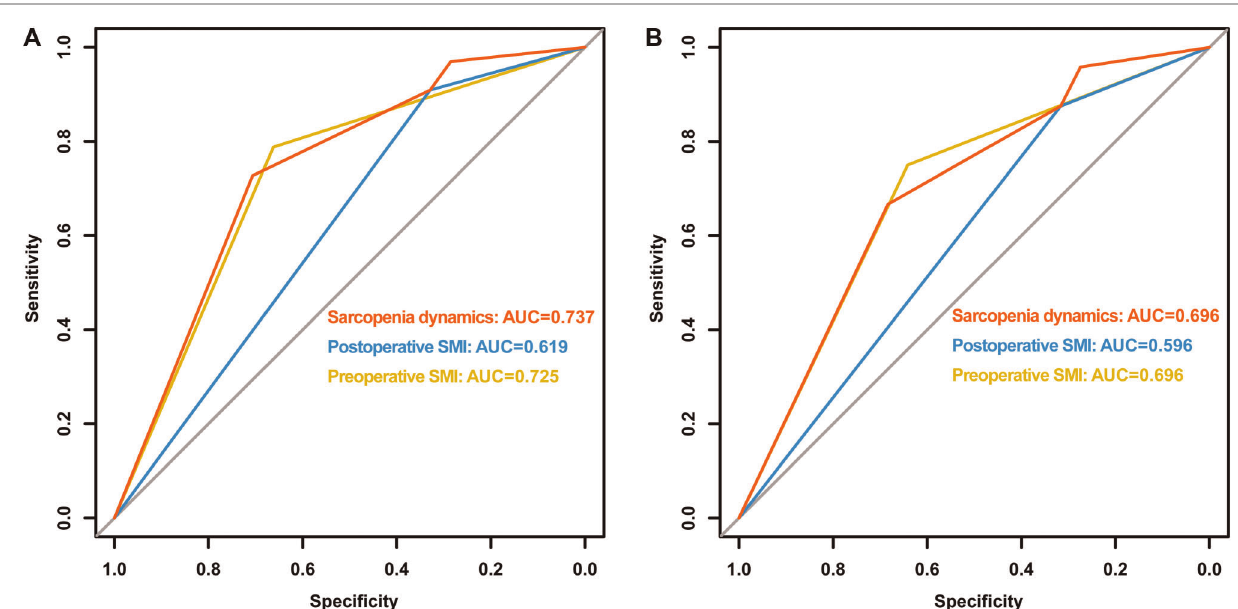
FIGURE 4 | Comparison of area under ROC curves for preoperative SMI, postoperative SMI and sarcopenia dynamics. ( A ) OS ROC curves; ( B) CSS ROC curves. Abbreviations: OS, overall survival; CSS, cancer-speci fi c survival; ROC, receiver operator characteristic; AUC, area under the curve; SMI, skeletal muscle index.